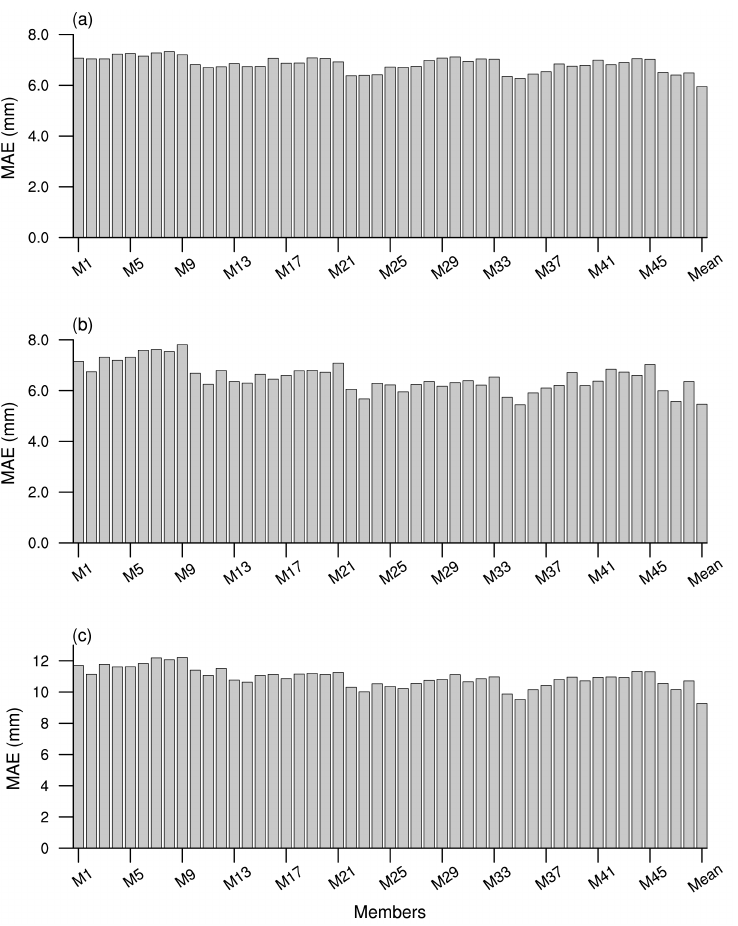
Figure 7. The four-case averaged MAE (mm) for each ensemble member during 12:00–23:00 UTC ( a ), 00:00–11:00 UTC ( b ), and 24 h ( c ). Table 6. The STD (mm) values of RMSE for 48 ensemble members during three